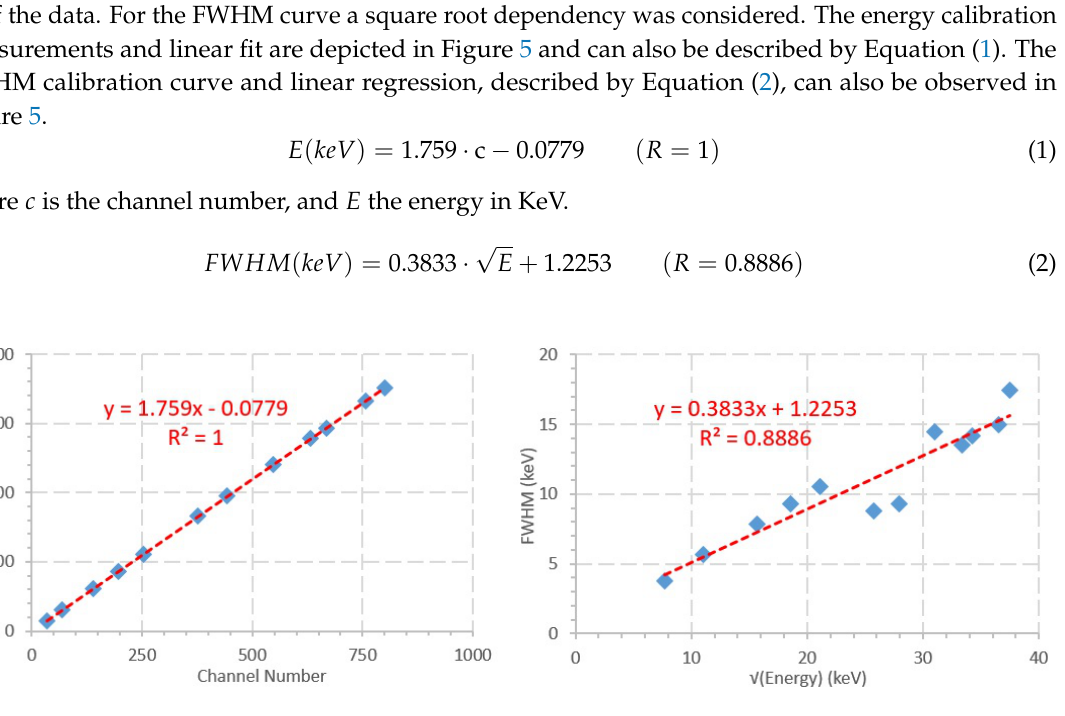
Figure 5. Energy ( left ) and FWHM ( right ) calibration of the considered peaks, showing the linear regression equations and R